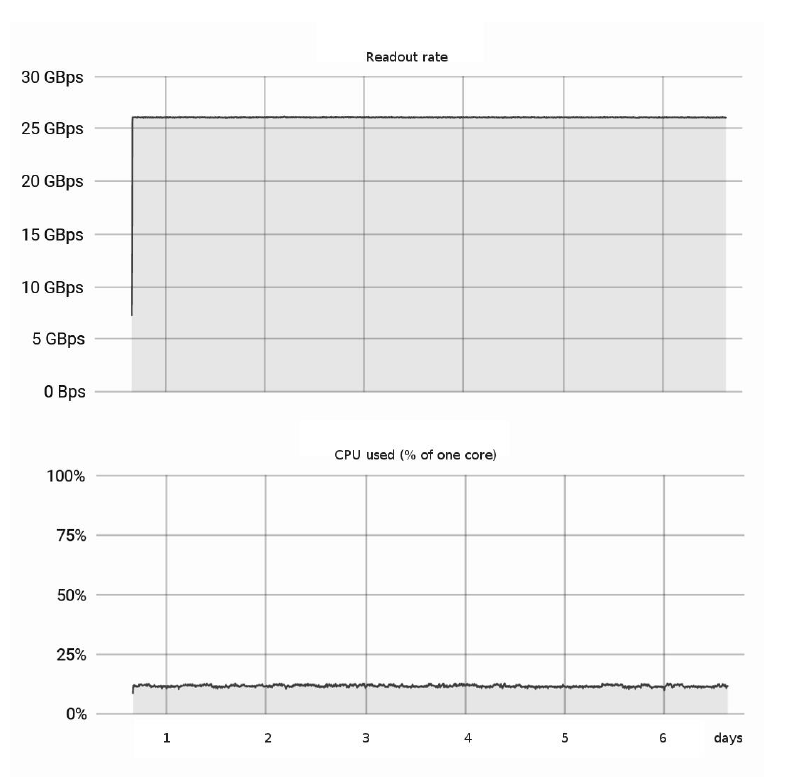
Fig. 2. CRU throughput and CPU resources of readout running on a dual-CRU